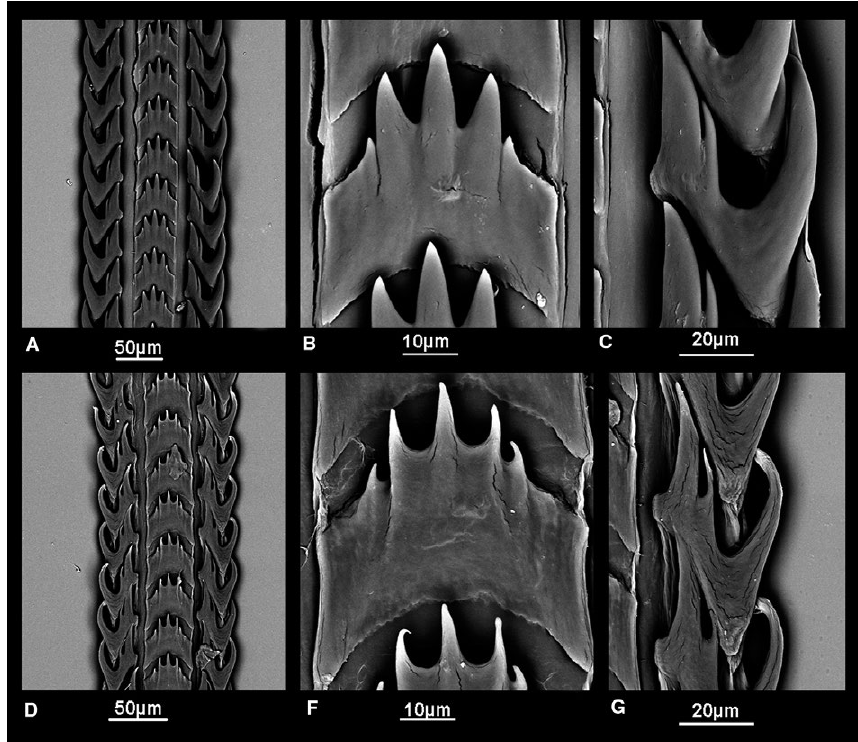
Fig. 5. – Morphology of radula with detail of central and lateral teeth in the Aplus dorbignyi complex. A-C, Aplus assimils , Bizerte, Tunisia (MNHN IM-2013-32513). D-E, Aplus dorbignyi , Djerba, Tunisia (MNHN M-2013-31697). Scale bars 50 μm (A, D), 10 μm (B, E) and 20 μm (C,